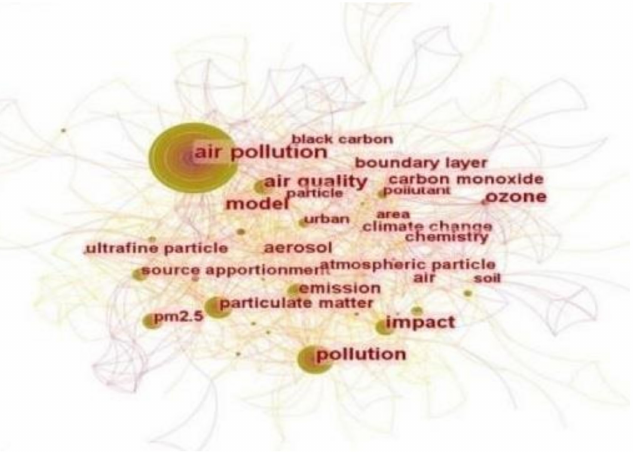
Figure 3. Co-occurrence map of air pollution governance for the period 2000 to